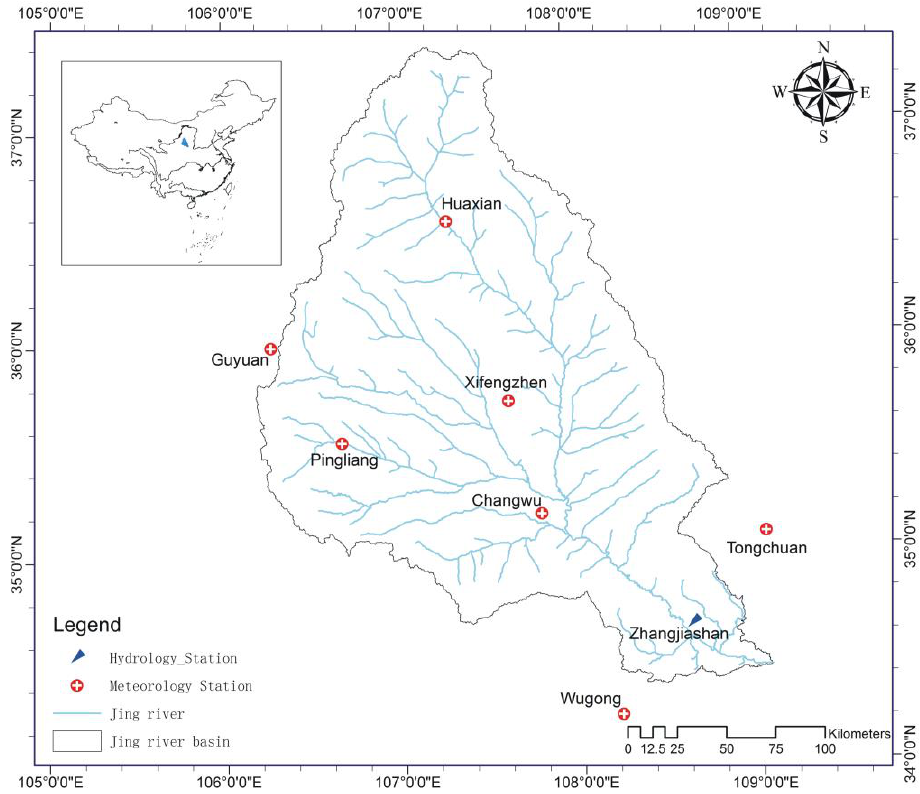
Figure 1. The locations of the hydrological and meteorological stations in the Jing River Basin.